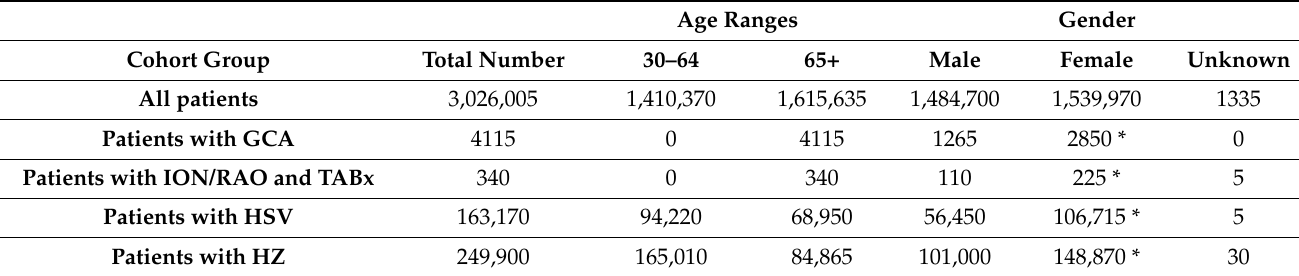
Table 1. Demographic summary of study population as available from BC Data Scout TM .